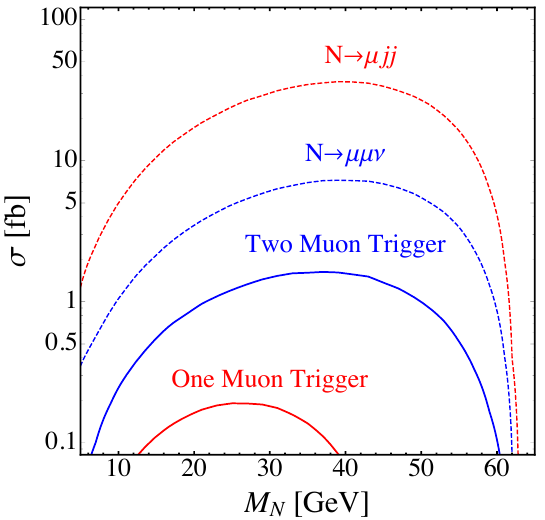
Figure 5 . Cross section for Channel 1 and Channel 2 as a function of the RH neutrino mass before (dashed) and after (solid) the corresponding kinematical cuts. The dashed red line represents the theoretical prediction for (cid:27) ( pp h 1 NN N(cid:22)jj ), while the solid red line corresponds ! ! ! to the cross section after the one muon selection, eq. (5.2). Likewise, the dashed blue line